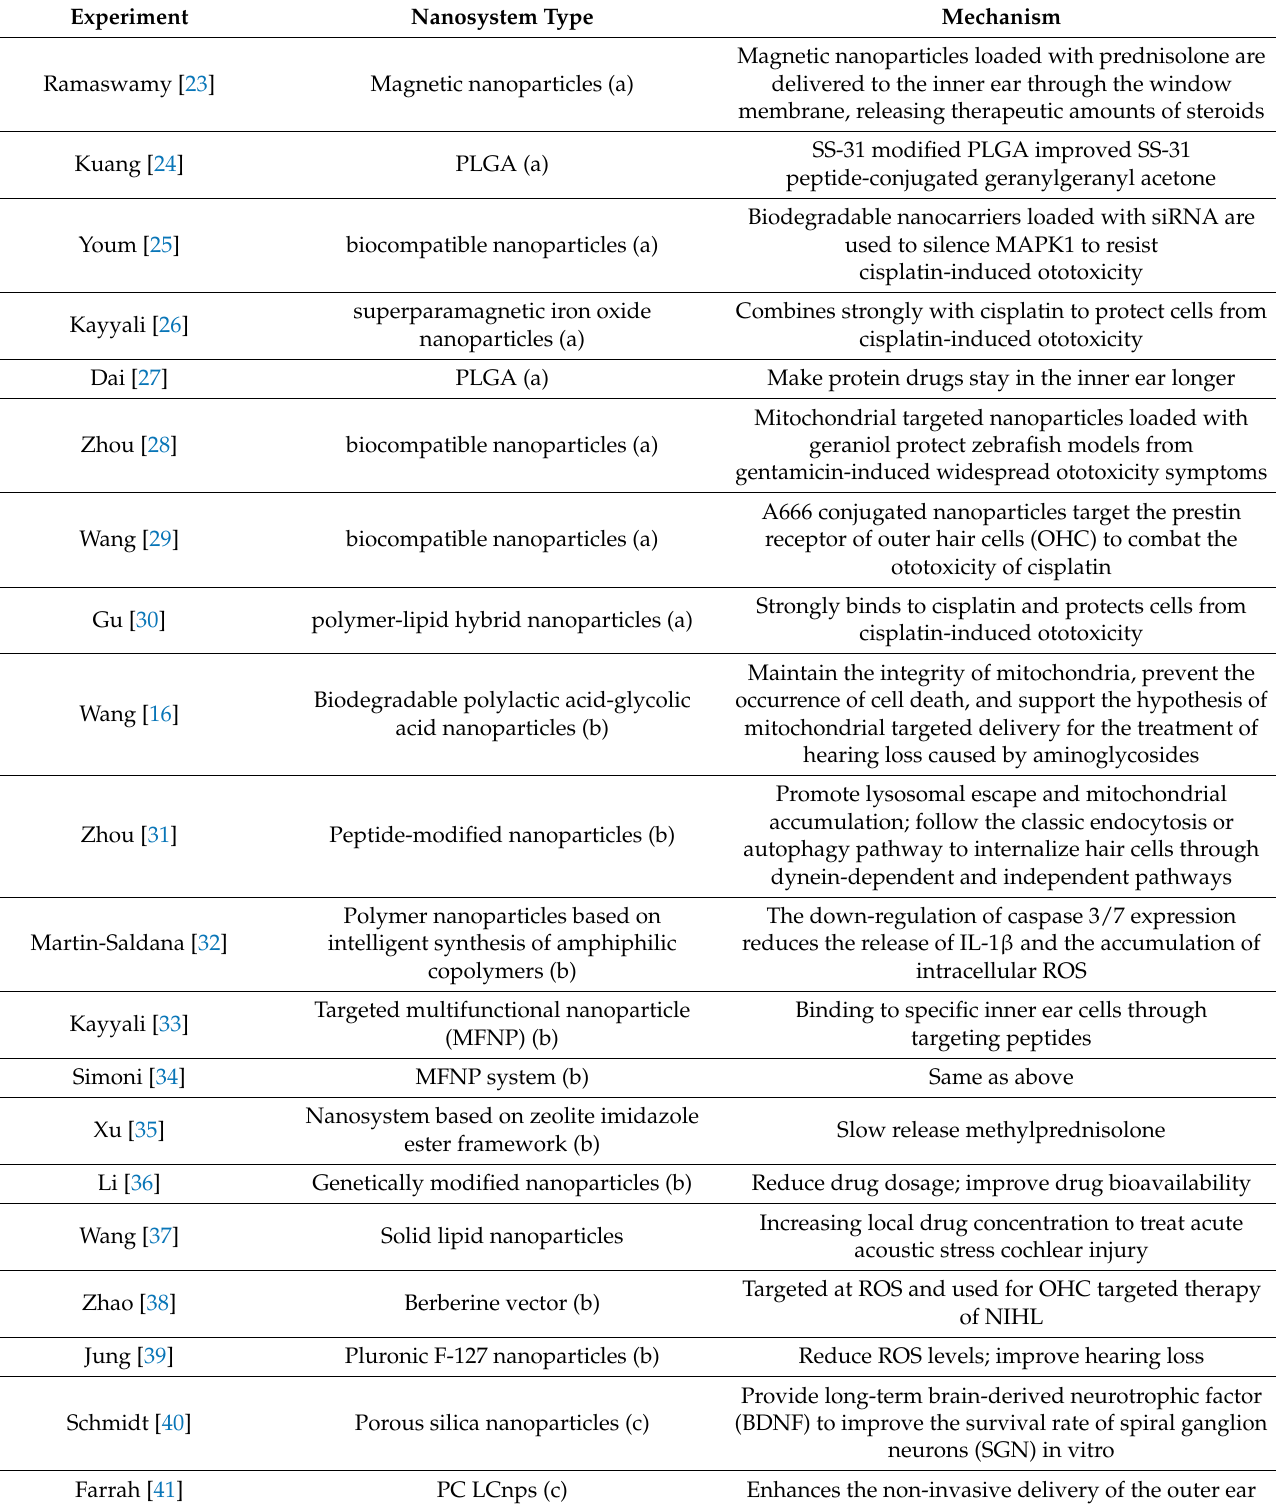
Table 4. The application mechanism of nanoparticles in drug carriers. (a) Experiments related to